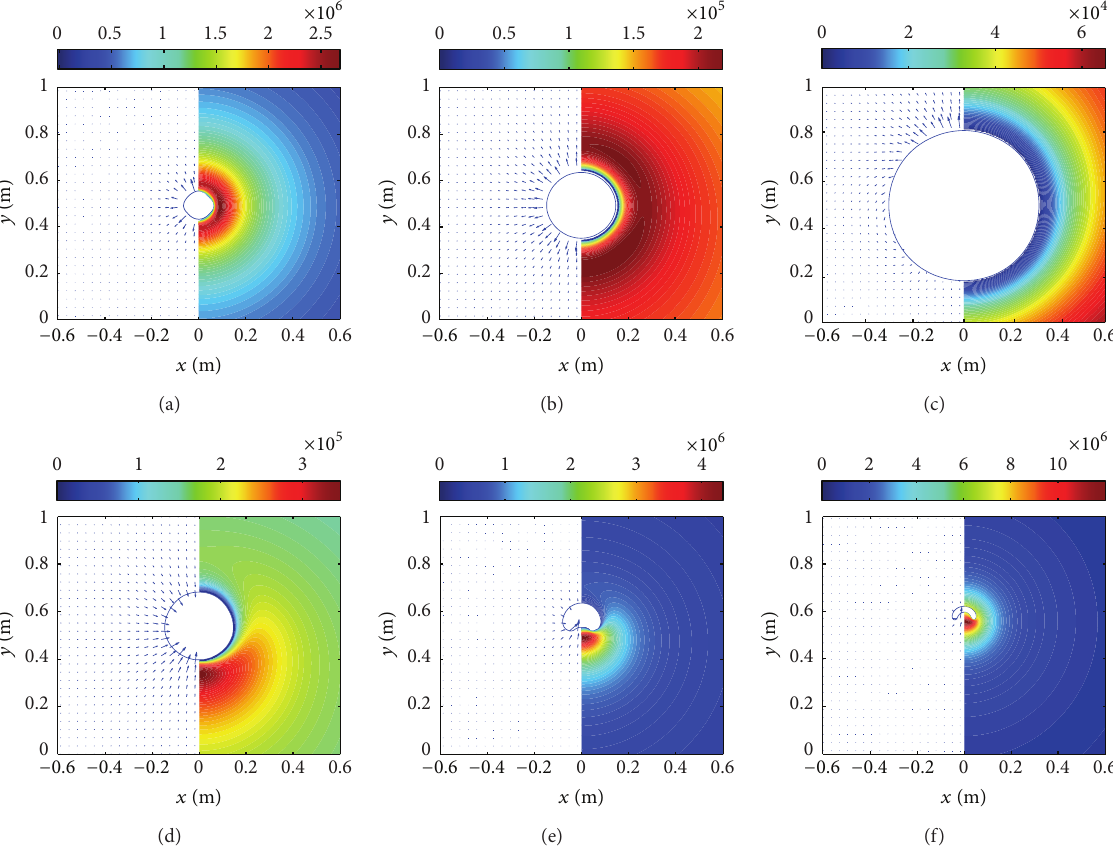
Figure 5: Bubble pulsing process (the left one is the velocity vector distributions and the right one is the pressure nephograms; from left to right the times are (a)–(c) 0.26 ms, 0.86 ms, and 22.48 ms; (d)–(f) 42.76 ms, 44.43 ms, and 44.69